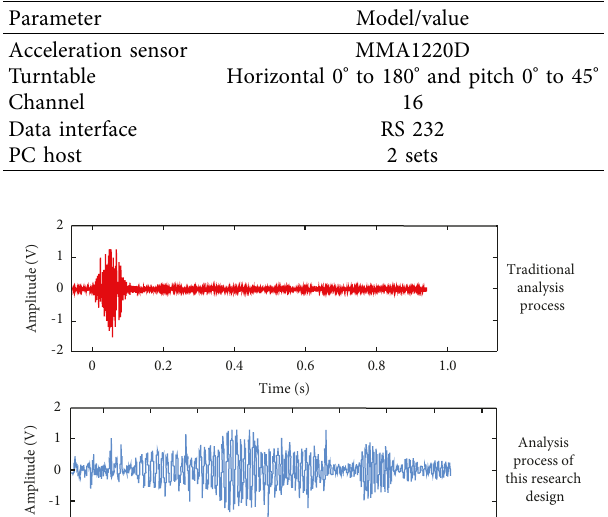
Table 1: Setting of experimental